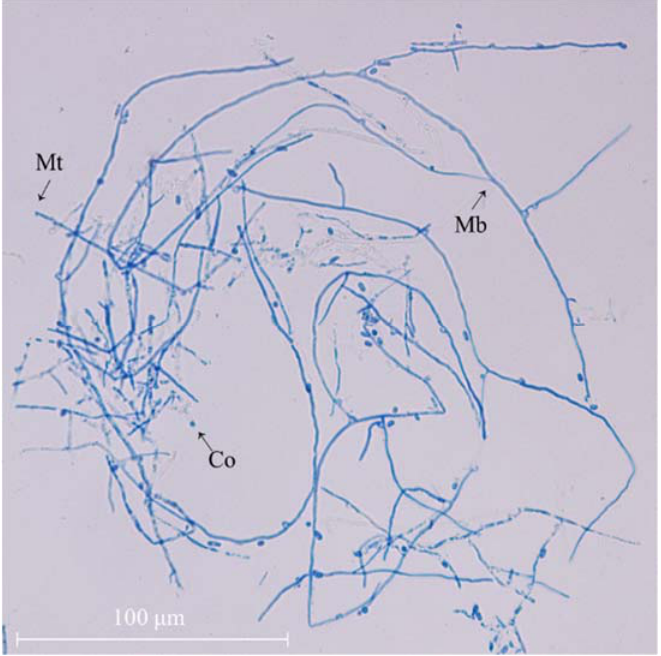
Figure 1. Mycelial morphology of A. camphorata mycelia (×40). Co, conidia; Mb, mycelium branch; Mt, mycelium tip.